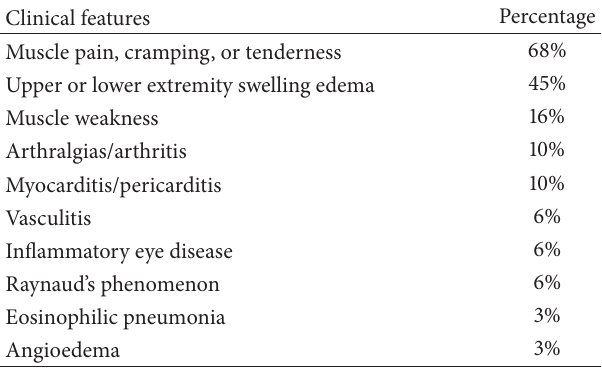
Table 1: Signs and symptoms of eosinophilic myositis [18].